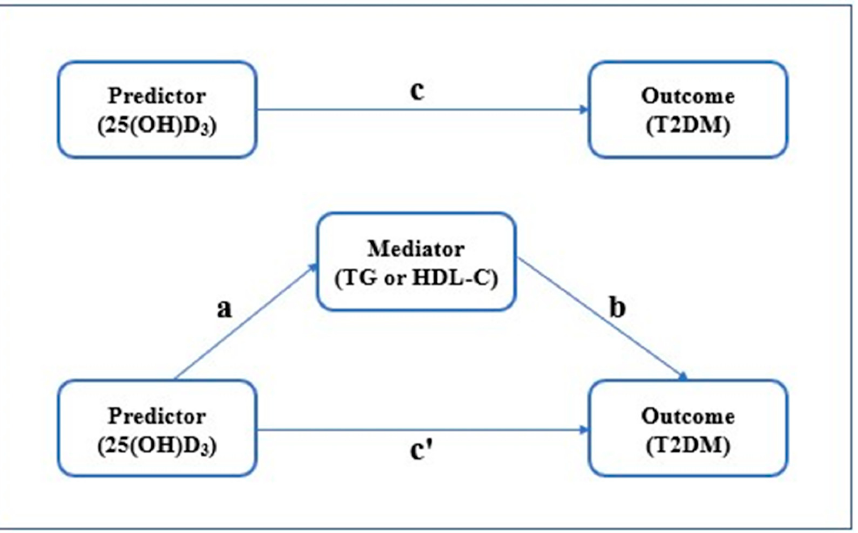
Figure 5. The mediation model: “a” represents the path from 25(OH)D 3 (Predictor) to TG (Mediator), “b” represents the path from TG or HDL-C (Mediator) to T2DM (Outcome), “c” represents the path from 25(OH)D 3 (Predictor) to T2DM (Outcome), and “c’” represents the path from 25(OH)D 3 (Predictor) to T2DM (Outcome) after TG or HDL-C (Mediator) is controlled.